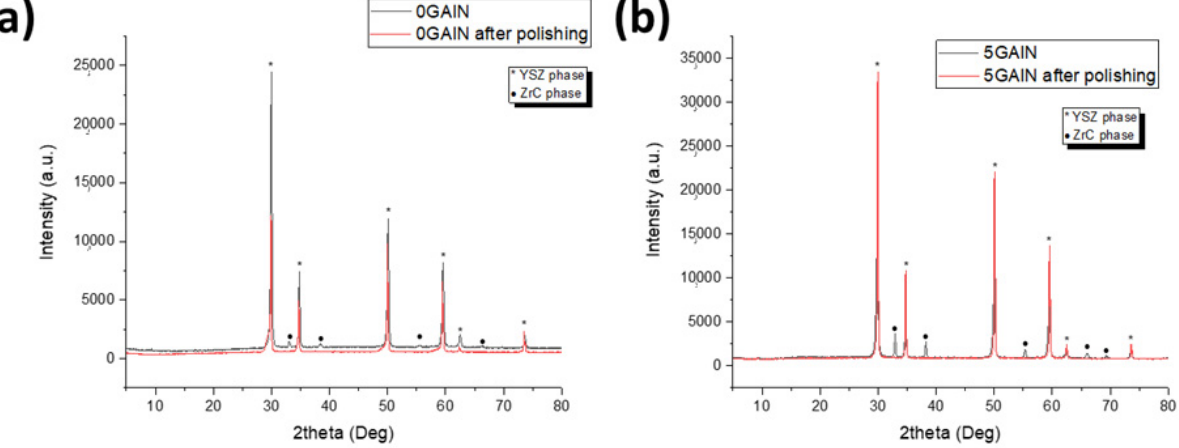
Figure 2. XRD patterns of obtained YSZ-GAlN composites. A comparison of XRD patterns for 0 GAlN and 5 GAlN composites after synthesis and polishing with a diamond suspension is present in Figure 3. Polishing results in ZrC removal from the surface and characteristic peaks for the ZrC phase at 2 Θ = 34, 38, 55, 66 and 69° are absent in the following XRD patterns. So, one can see that the reaction between YSZ powder and graphite takes place only on the thin surface layer of the composite during SPS.